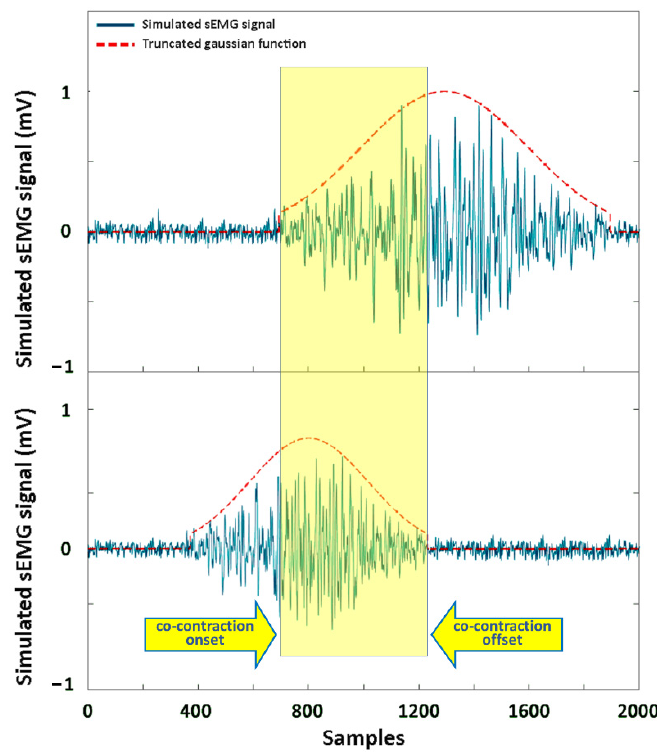
Figure 2. Example of two simulated sEMG signals (in blue), suitable for co-contraction detection. Truncated Gaussian function used to simulate the sEMG activity of each muscle is depicted in dashed red lines. Yellow area represents the co-contraction interval between the two signals. The two yellow arrows indicate the onset and the offset of simulated co-contraction, adopted as ground truth.